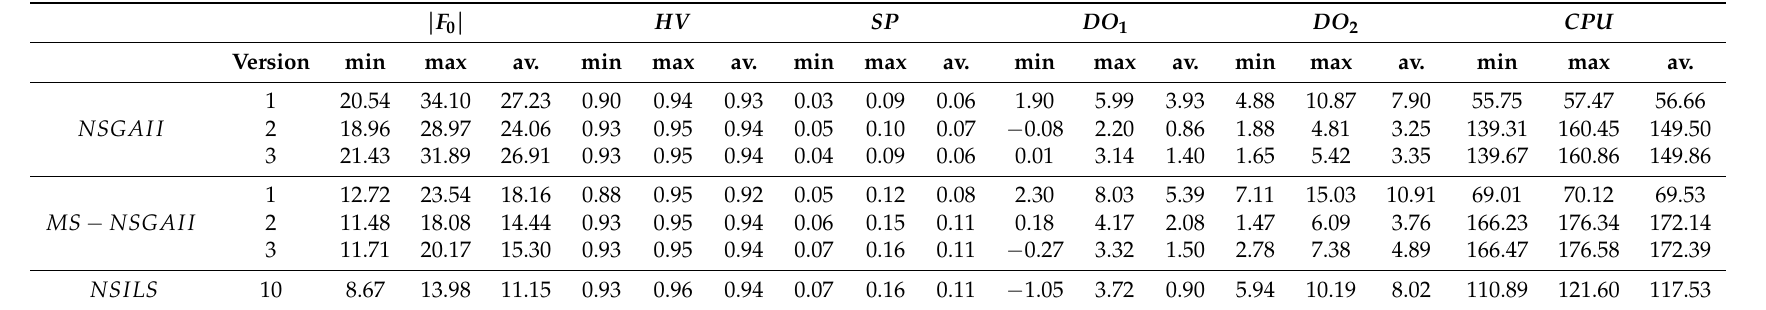
Table 9. Average results for the 7 versions on 37 instances. av.,